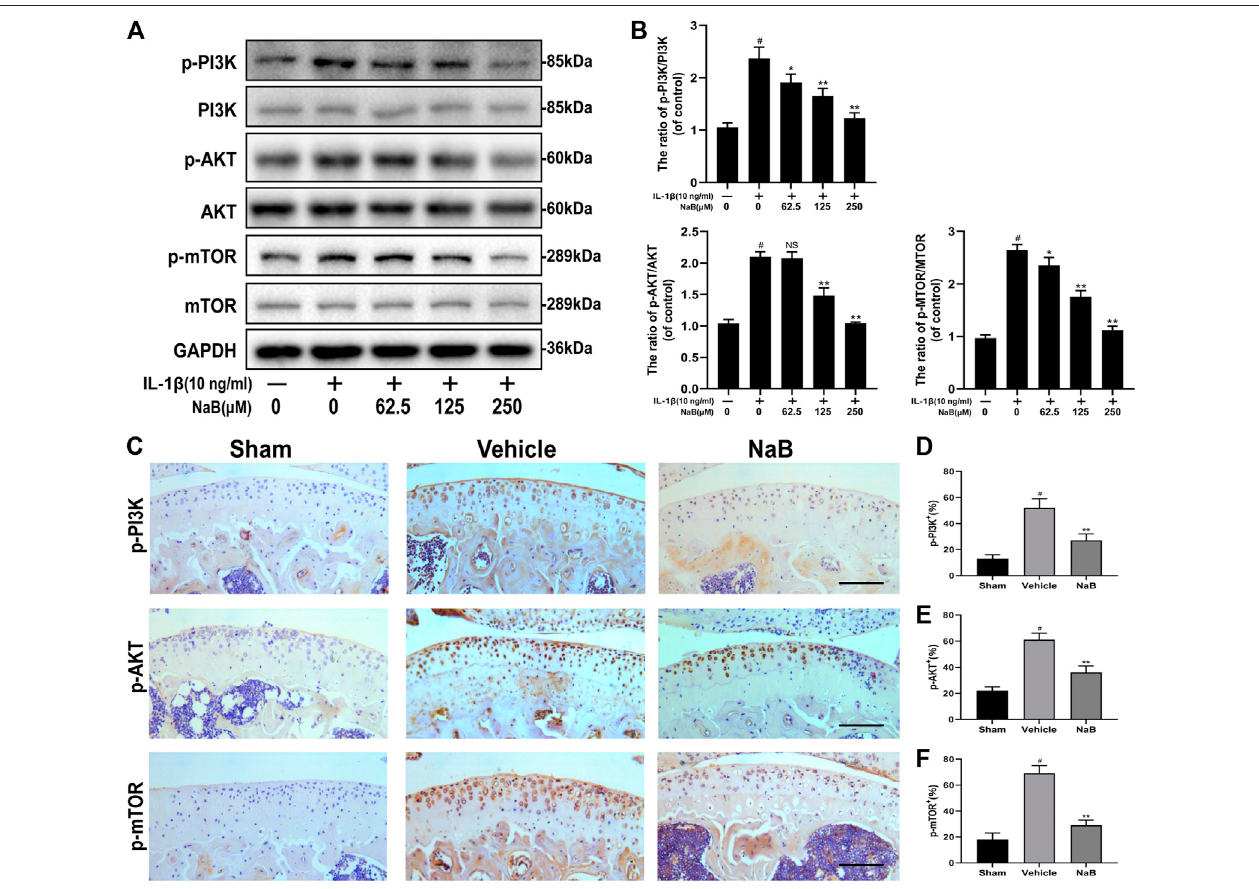
FIGURE 9 | Sodium butyrate (NaB) arrests the PI3K/Akt/mTOR signaling pathway in vitro and in vivo . Chondrocytes were pretreated for 2 h with several concentration gradients of NaB and were then stimulated with IL-1 β for 24 h (A,B) The protein expression levels of PI3K, p-PI3K, Akt, p -Akt, mTOR, and p -mTOR in chondrocyteswereassessed ( n (cid:2) 3). (C) Immunostainingofp-PI3K, p -Akt,and p -mTOR60 days postoperation andquanti fi cation (D – F) ;scalebar, 100 μ m; n (cid:2) 10per group.Thedataarepresentedasthemean ± S.D.Signi fi cantdifferencesbetweengroupsweredeterminedbyone-wayANOVA;* p < 0.05and** p < 0.01vs.IL-1 β - induced group or the vehicle group; # p < 0.01 vs. control group or thesham group; NS (not signi fi cant) vs. control group or thesham group. PI3K, phosphoinositide 3-kinase; Akt, protein kinase B; mTOR, mammalian target of rapamycin; IL-1 β , interleukin-1 β